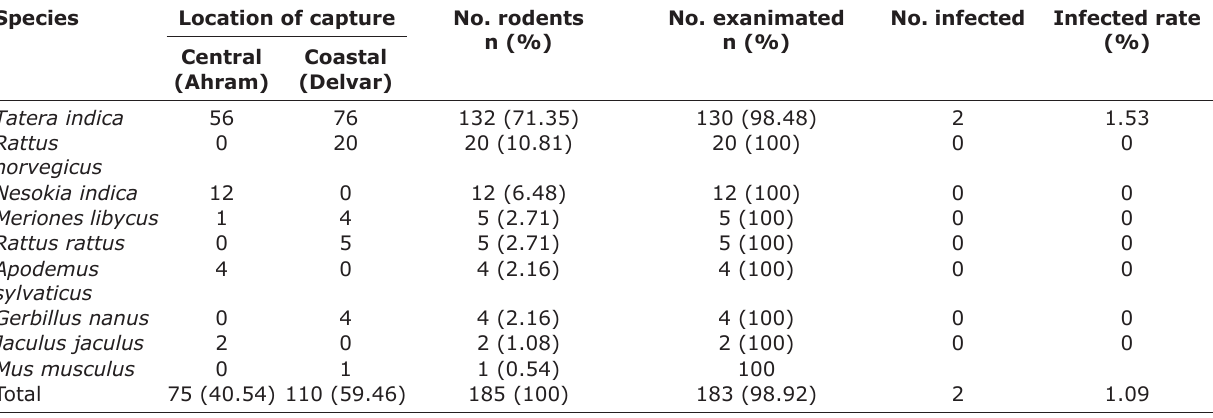
Table-2: Leishmania infection rate in different species of rodents in Tangestan County. Species Location of